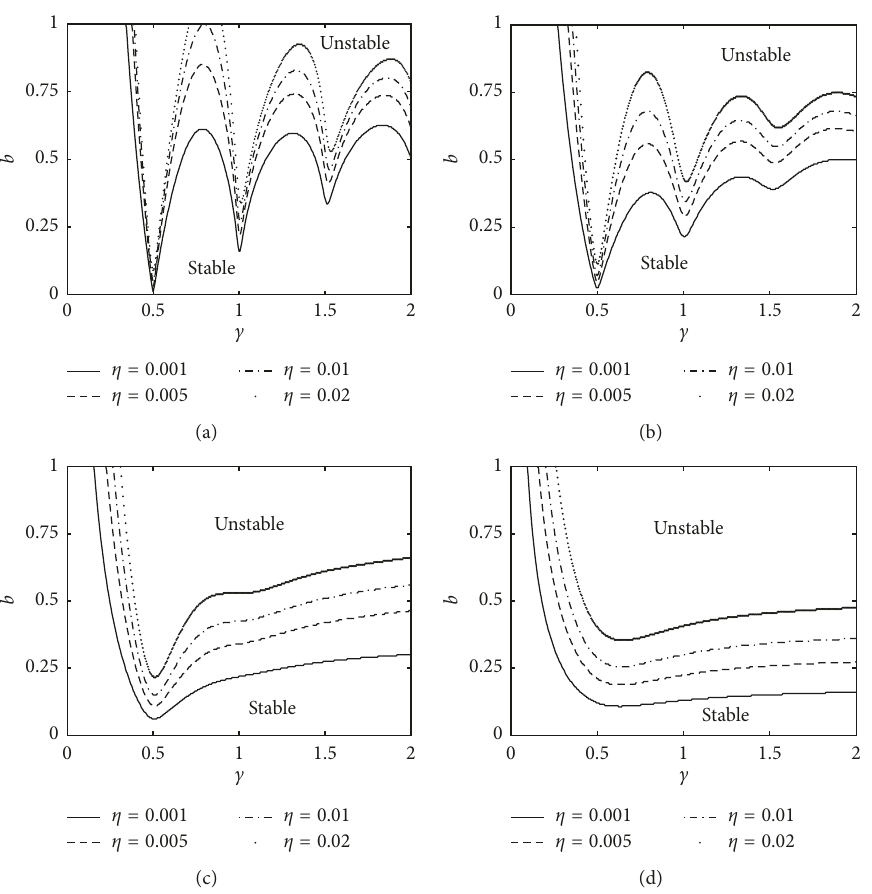
Figure 2: The influence of η on the transition curves on mean square stability charts of equation (8) for (a) c 0 . 1; (b) c 0 . 2; (c) c 0 . 5; (d) c 1 . (cid:29) (cid:29) (cid:29) (cid:29)